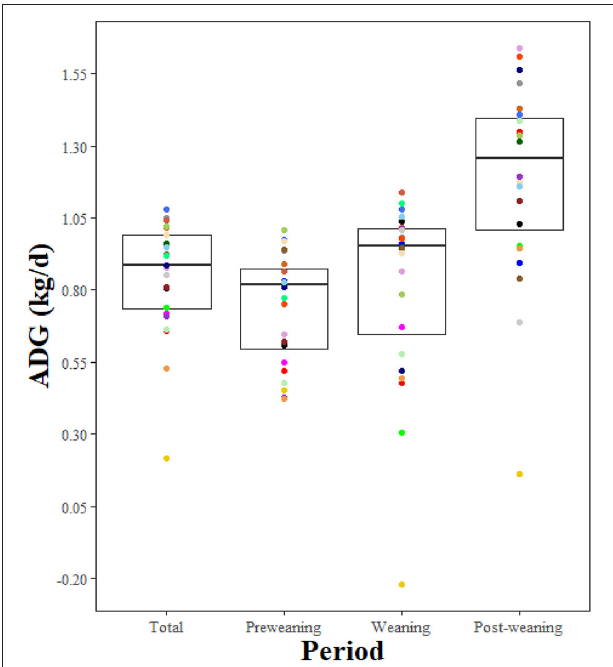
FIGURE 5 | Boxplots showing the median (line) and interquartile range (box) of the average daily gain (ADG) for all calves for each rearing period: enrollment in the study to unenrollment (Total), the full milk allowance period (Pre-weaning ADG), the stepdown milk period (Weaning), and the no milk allowance period (Post-weaning). Each color represents an individual calf.